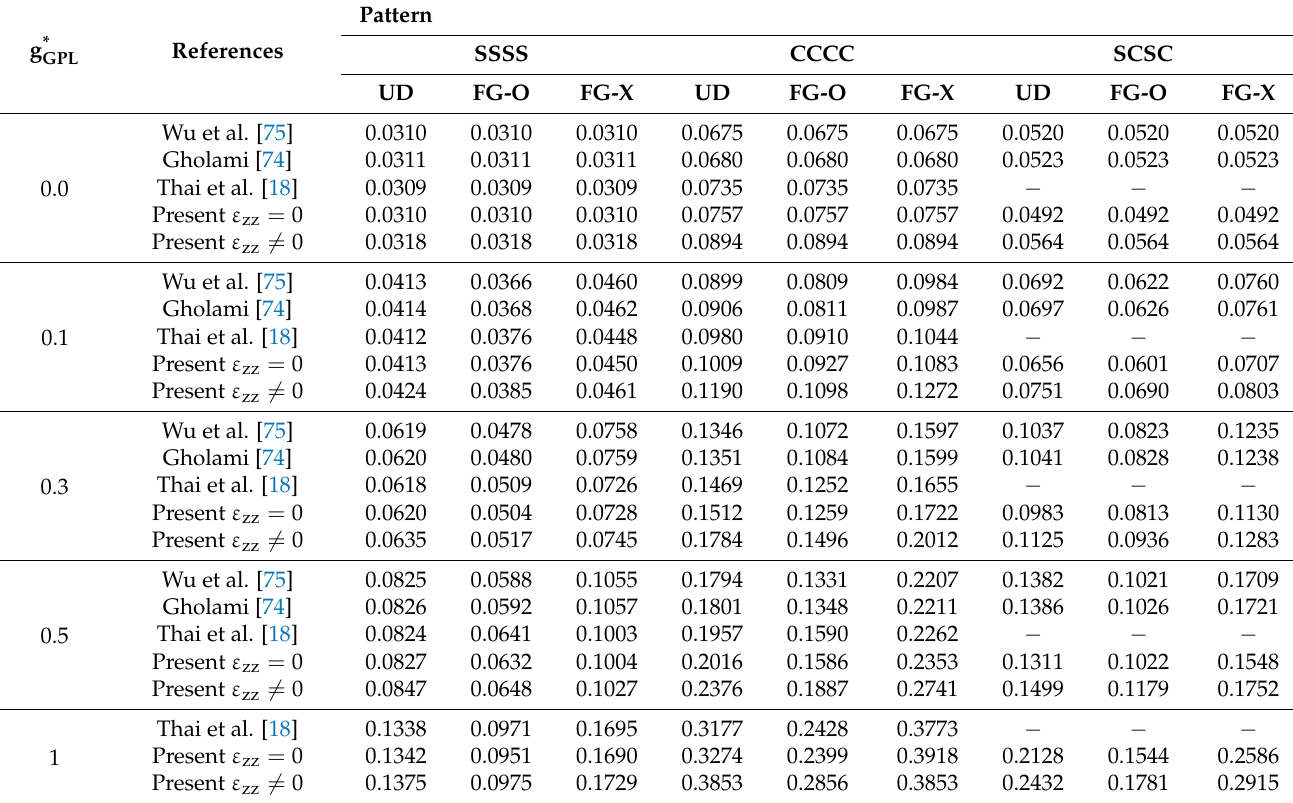
Table 3. This analysis is related to the buckling of functionally graded graphene reinforced composite square plates with thickness h = 0.045 m and length a = 0.45 m. Table 3. Dimensionless critical buckling load